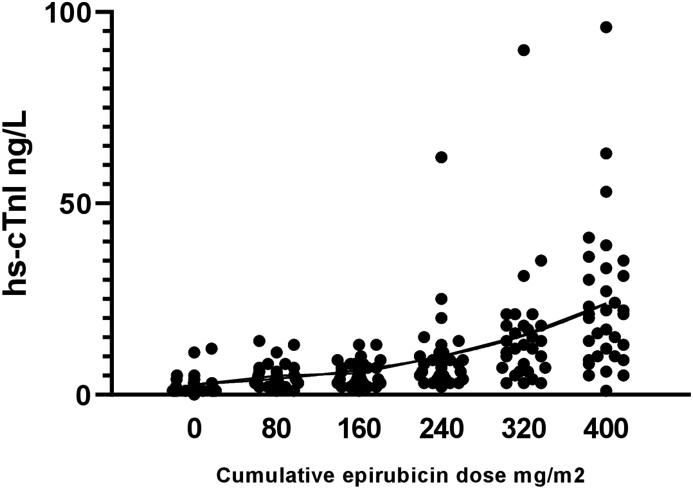
Correlation between circulating high-sensitivity cardiac troponin I (hs-cTnI) concentration and cumulative epirubicin dose. Scatterplot of individual patient hs-cTnI concentrations according to cumulative epirubicin dose (n = 78).